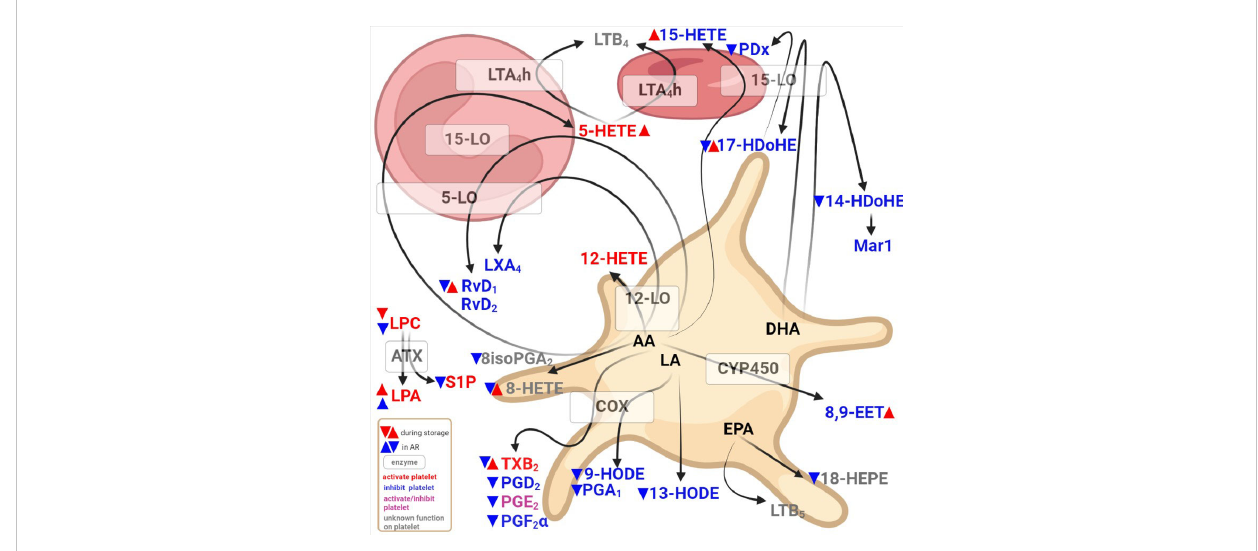
FIGURE 7 Diagram showing bioactive lipid detected in single donor apharesis during storage in the event of adverse